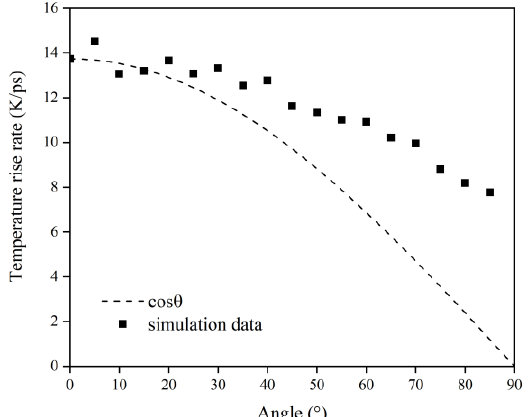
Figure 16. Temperature variation of the Kapton under atomic oxygen impact with different incidence angles.